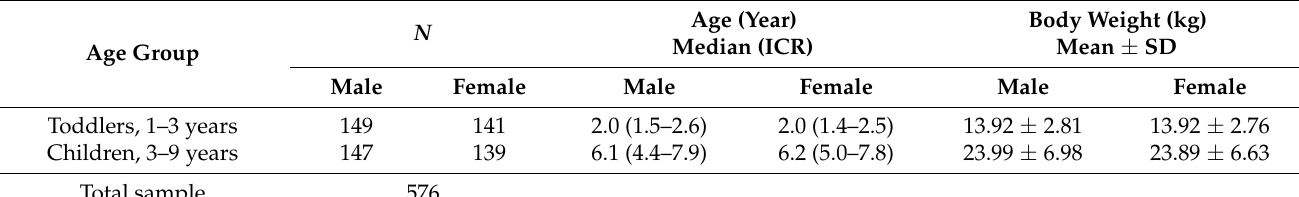
Table 1. Characteristics of the study